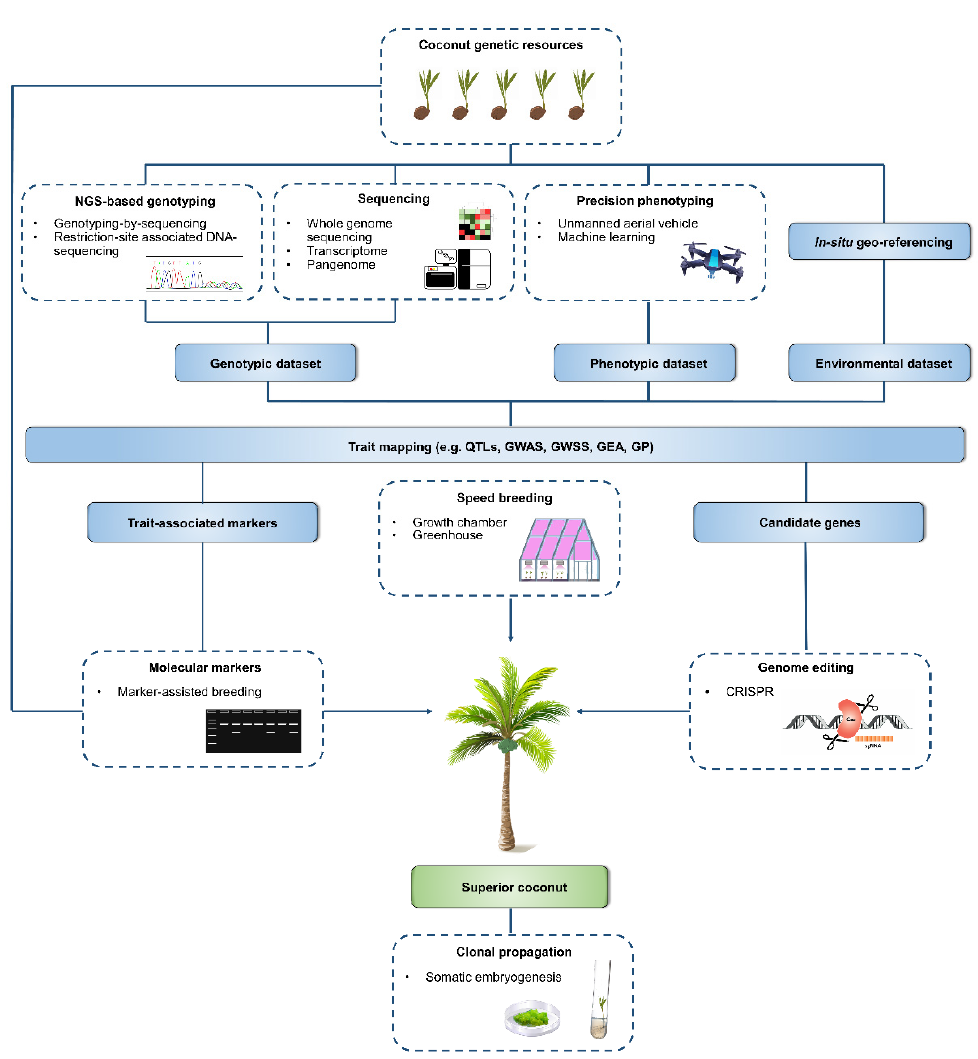
Figure 1. Utilizing and integrating various modern breeding technologies for genetic improvement in coconut. Coconut genetic resources such as conserved germplasm serve as a valuable source of new genetic variation. Next-generation sequencing-based genotyping approaches generate markers for genome analysis at a reduced complexity level. Next-generation sequencing platforms generate high-quality reference genomes and facilitate transcriptome as well as pangenomic analyses. Precision phenotyping expedites acquisition of phenotyping data of a large population in the field. The integration of these three approaches provides a powerful means to link genetic variations with the relevant phenotypes, allowing trait mapping using various approaches such as quantitative trait loci (QTL) and genome-wide association studies (GWAS). In situ georeferencing from genotypically characterized germplasm generates environmental dataset. The combination of genomic tools with environmental variables allows identification of adaptive trait loci associated with abiotic stresses via genome-wide selection scans (GWSS), genome-environment associations (GEA) [61], and ge- nomic prediction (GP). The identification of trait-associated markers will facilitate the selection of individual palms based on their genotype in the breeding program. The molecular markers can be also utilized for characterization and evaluation of coconut germplasm. Once the candidate genes associated with the desired trait are identified, functional characterization can be performed using genome editing (e.g., using CRISPR) which enables a precise and accurate modification of targeted genes. Speed breeding will accelerate the entire coconut breeding progress. Clonal propagation al- lows rapid large-scale production of the new high-quality, abiotic stress tolerant, and biotic stress resistant coconut palms.